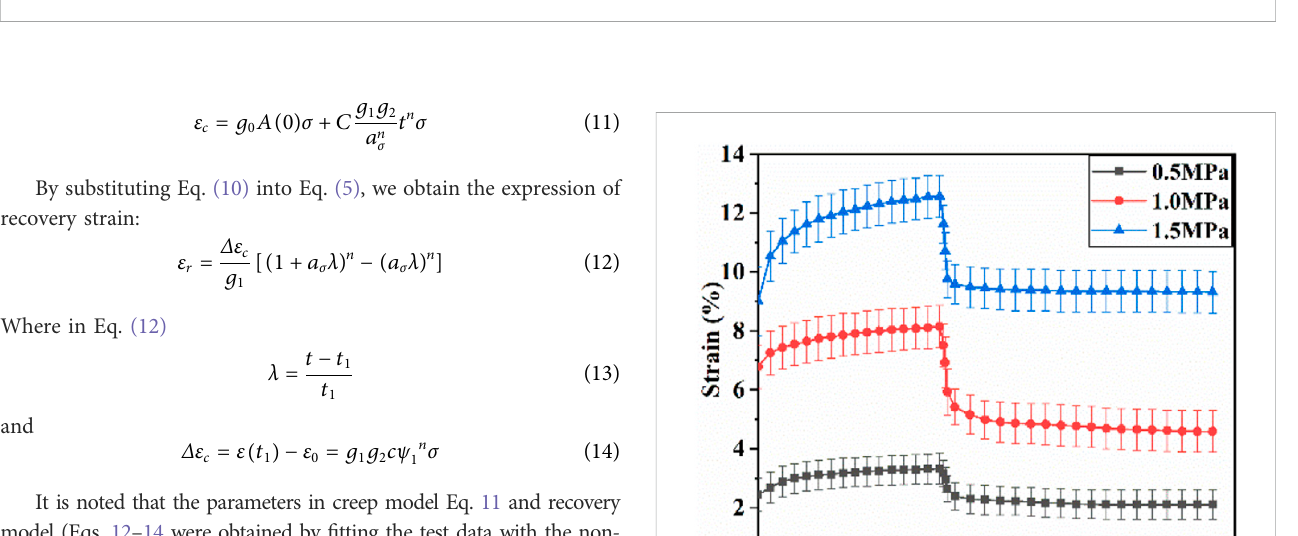
strain component at different stress.